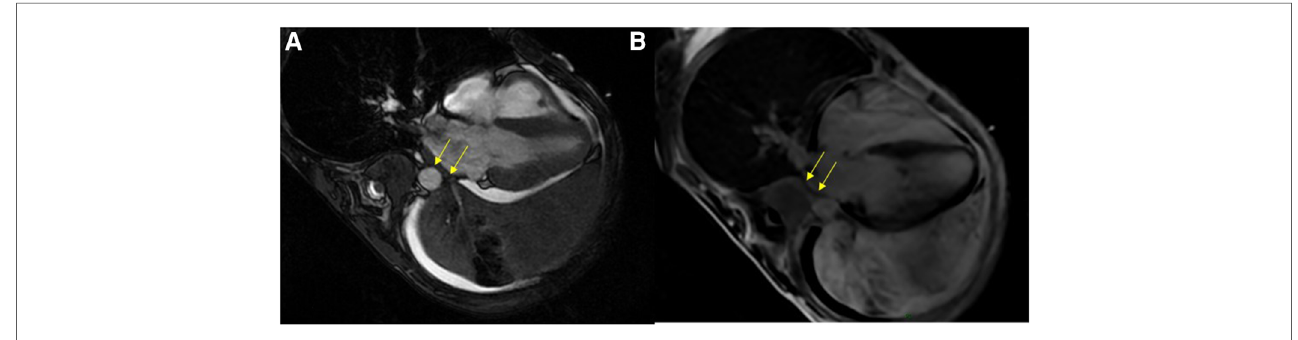
FIGURE 2 Cardiac MRI. SSFP four-chambers view showing the extensive tumoral process in the left pulmonary area coming into close contact with the left atrium, with paraneoplastic pleural and pericardial effusions ( A ); and likely tumoral invasion of the left atrial wall on the late-gadolinium-enhanced acquisition ( B ). MRI, magnetic resonance imaging; SSFP, steady-state free